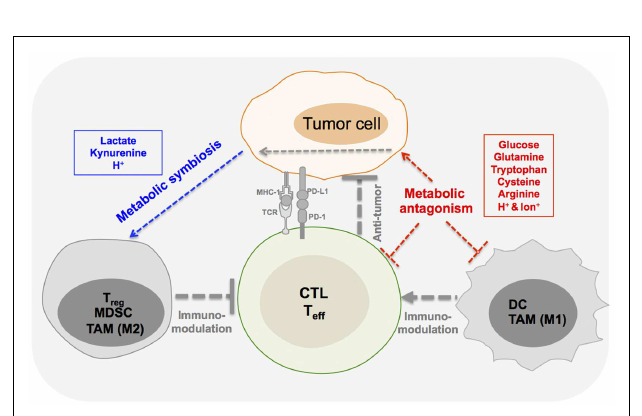
FIGURE 1 | Metabolic interplay in tumor immunity . Metabolic interplay through shuttling of metabolites among different cell compartments in tumor microenvironment serves as a form of intercellular communication and intercellular coordination.T effector cells (T eff ), cytotoxicT cells (CTL), dendritic cells (DC), and tumor-associated macrophage (TAM-M1) may form a potential metabolic antagonism (red color marked) with tumor cells. On the contrary,T regulatory cells (T reg ), myeloid-derived suppressor cells (MDSC), andTAM-M2 may preferentially utilize metabolic products of tumor to form a potential metabolic symbiosis (blue color marked) in tumor